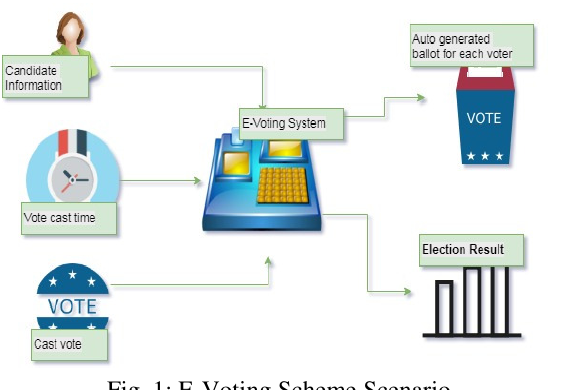
Fig. 1: E-Voting Scheme